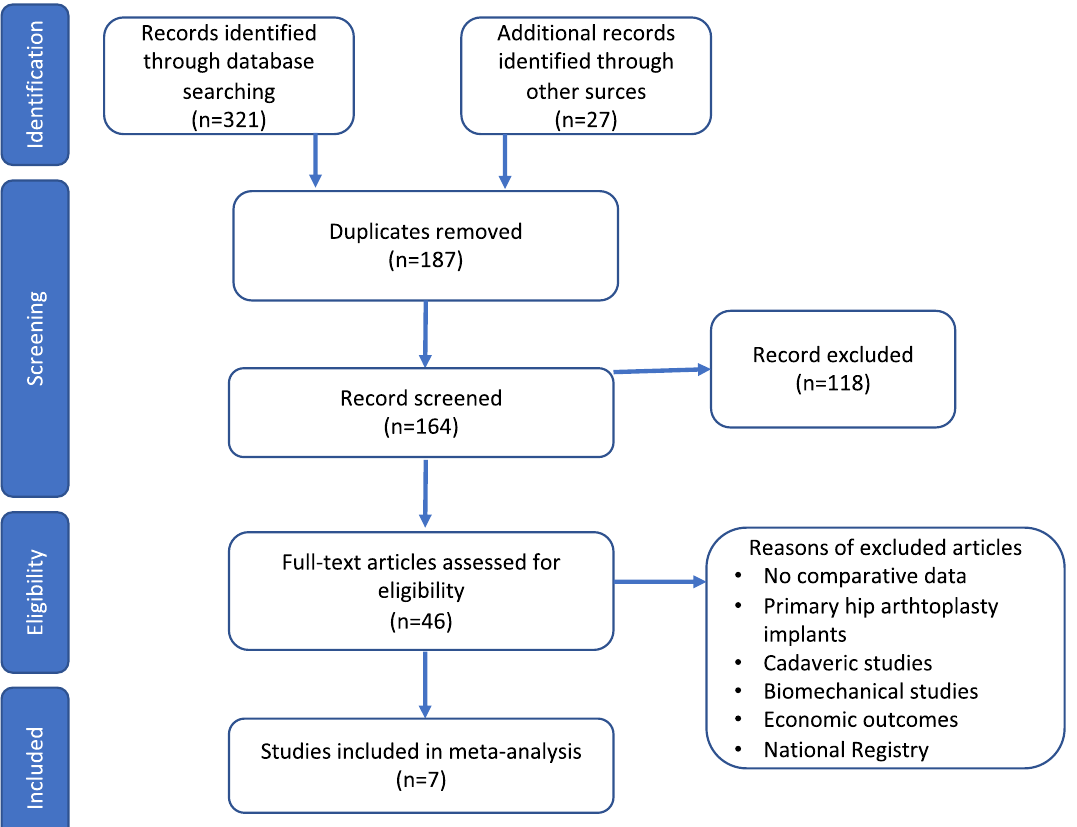
Figure 1. Quality of reporting of meta-analyses standards developed fl ow